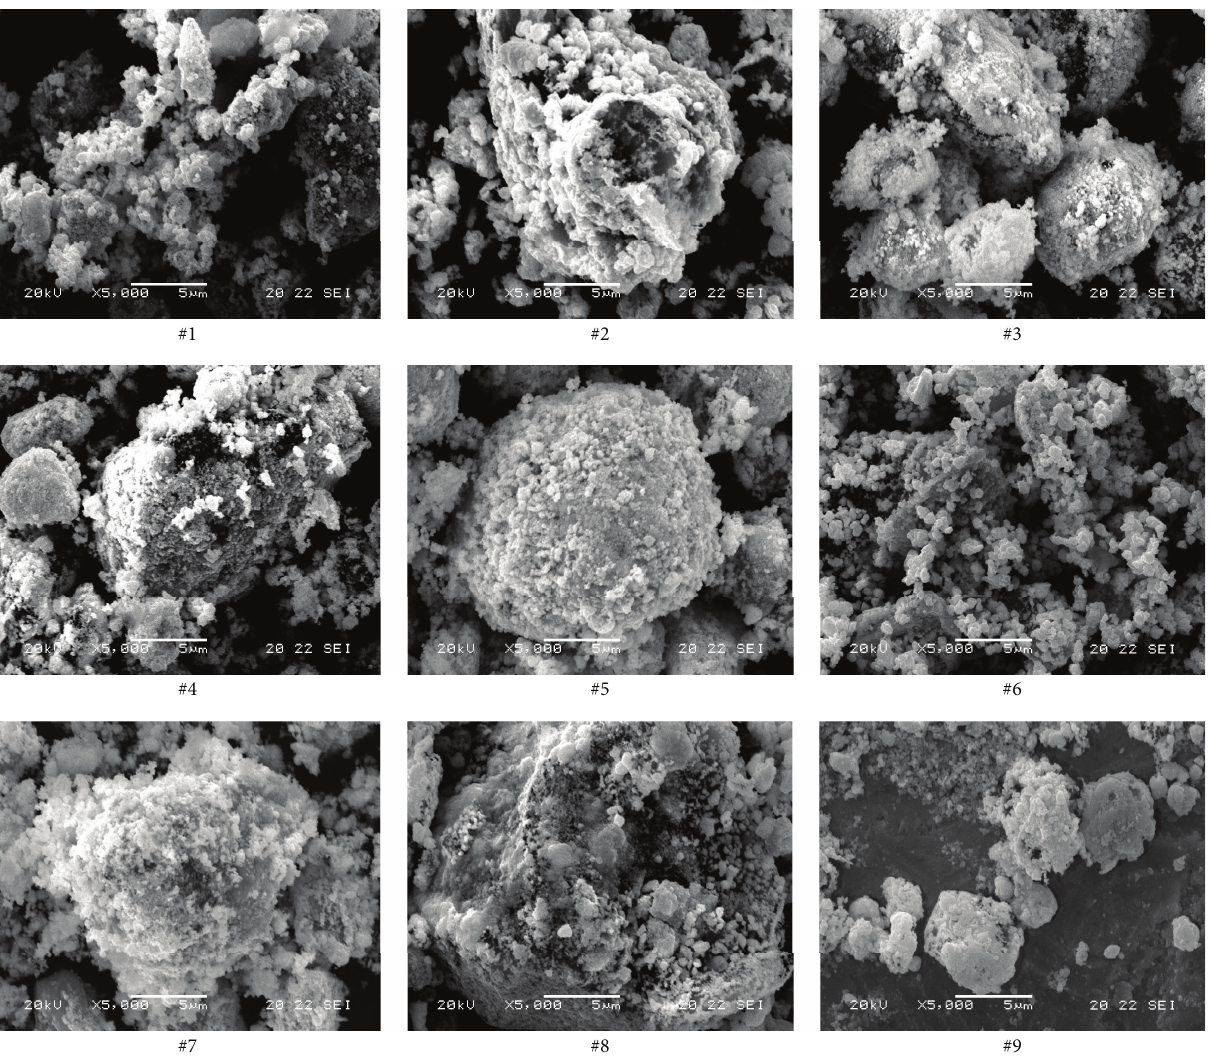
Figure 1: Micron size morphologies of nine Zuotai samples by scanning electron microscopy (SEM). Note: #1 is the sample of Aba Prefecture Tibetan Medicine Hospital; #2 is the sample of Gan’na Prefecture Tibetan Medicine Hospital; #3, #4, and #5 are the samples of the Company of Tibetan Medicine of Tibetan Traditional Medical College; #6, #7, and #8 are the samples of Qinghai Province Tibetan Medicine Hospital; #9 is the sample of the Company of Tibetan Medicine of Tibetan Autonomous